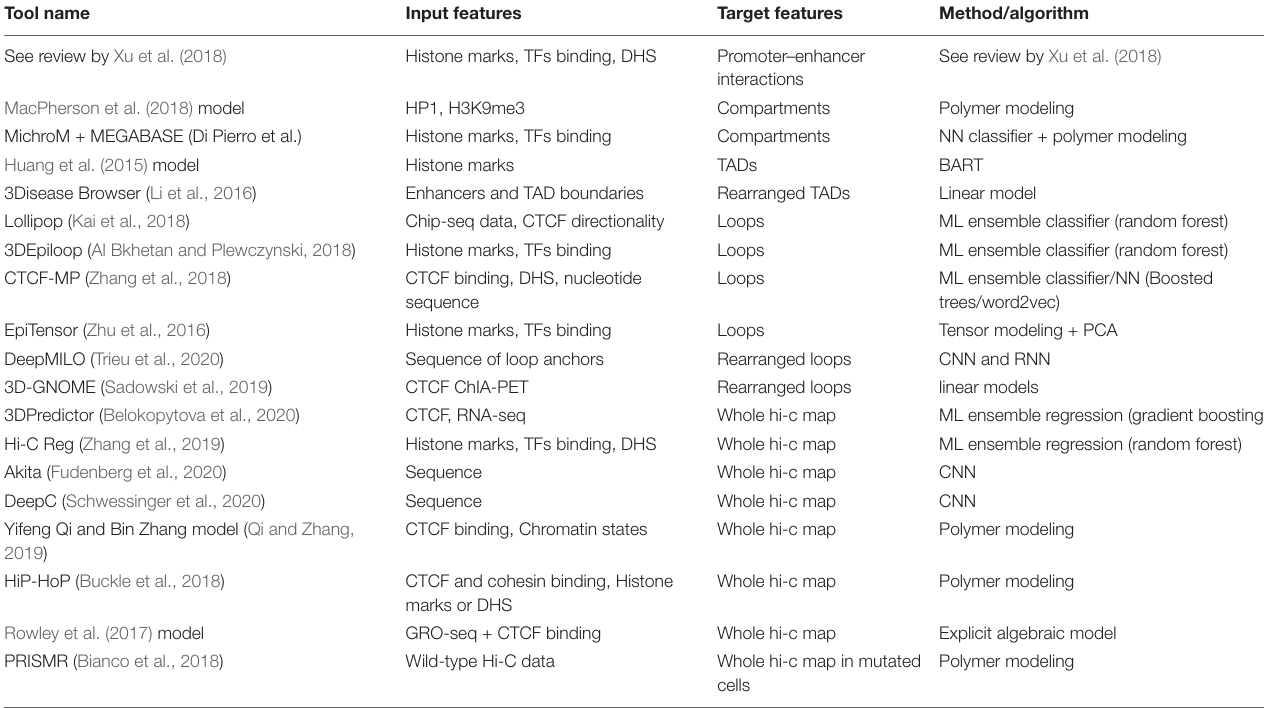
TABLE 1 | Tools for modeling and predicting chromatin